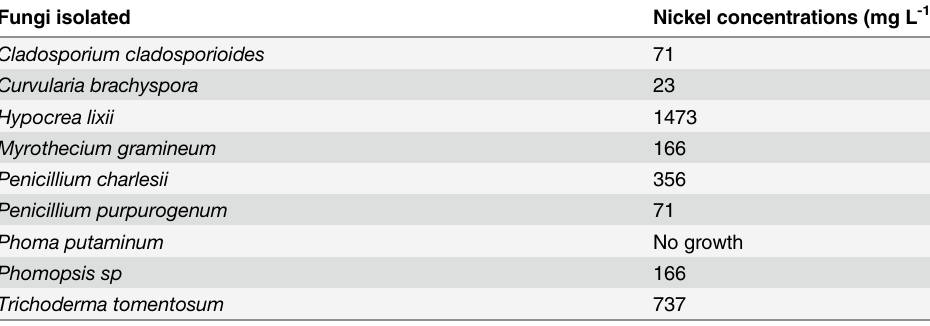
Table 1. Minimum inhibitory concentrations obtained for the fungi isolated from